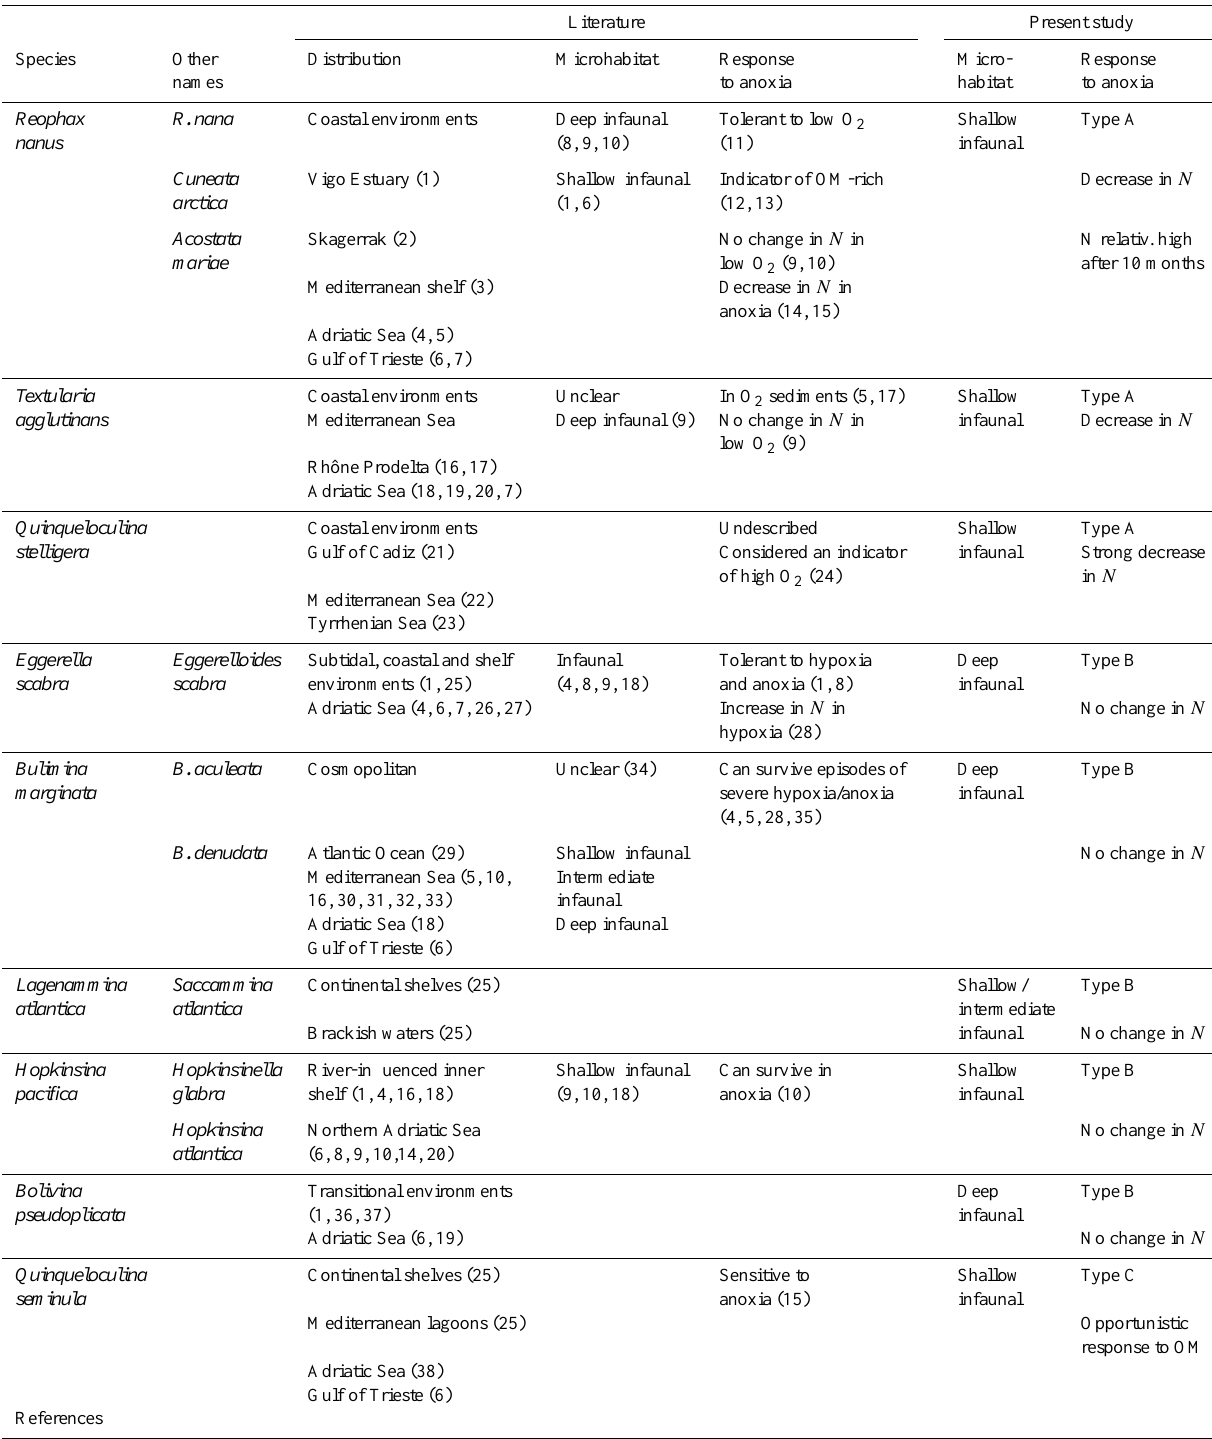
Table 8. Type of environment, microhabitat, and response to anoxia in the literature and in the present study for all the major species (their synonymous names are also given). Abbreviations: O 2 represents oxygen or oxygenated; OM, organic matter; N , density or standing stock; relativ., relatively; and M,